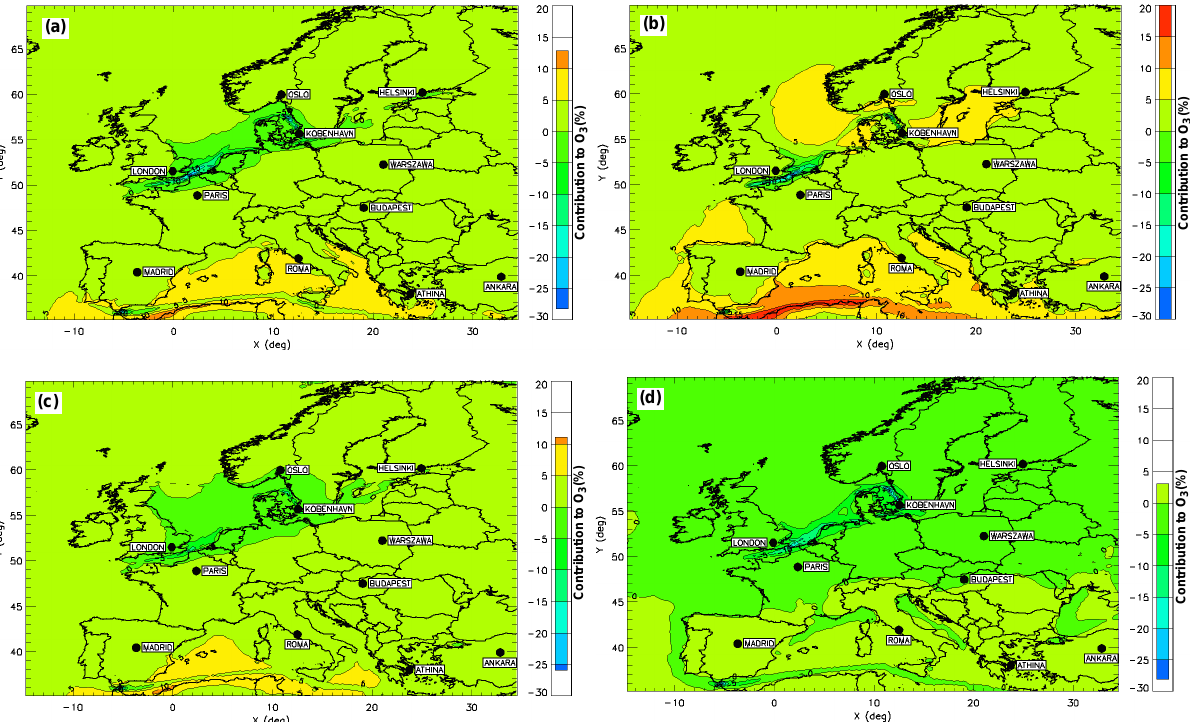
Figure 3. Contribution of ship emissions to mean surface O 3 (%) in (a) spring, (b) summer, (c) fall and (d) winter ((base case − no ship) × 100/(base